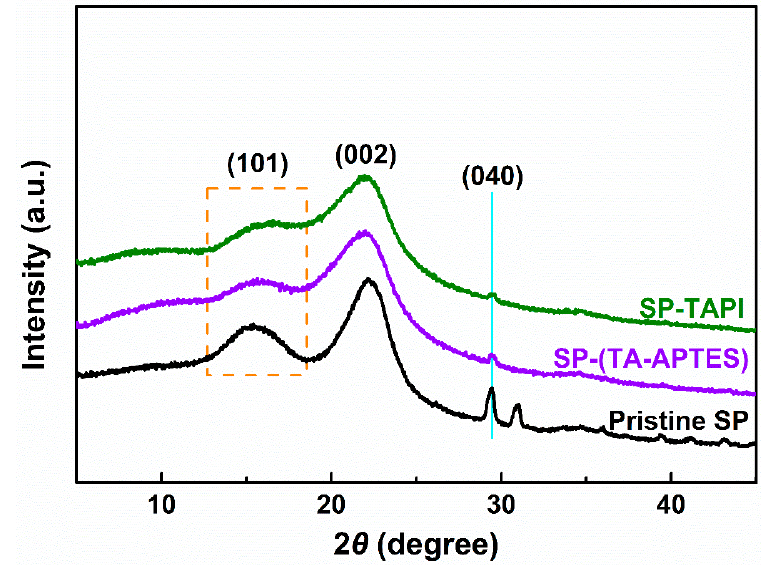
Figure 3. XRD patterns of pristine SP, SP-(TA-APTES), and SP-TAPI composites.